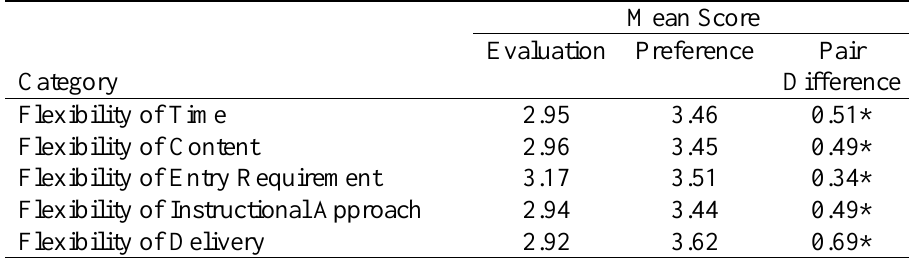
Mean scores of the flexibility categories